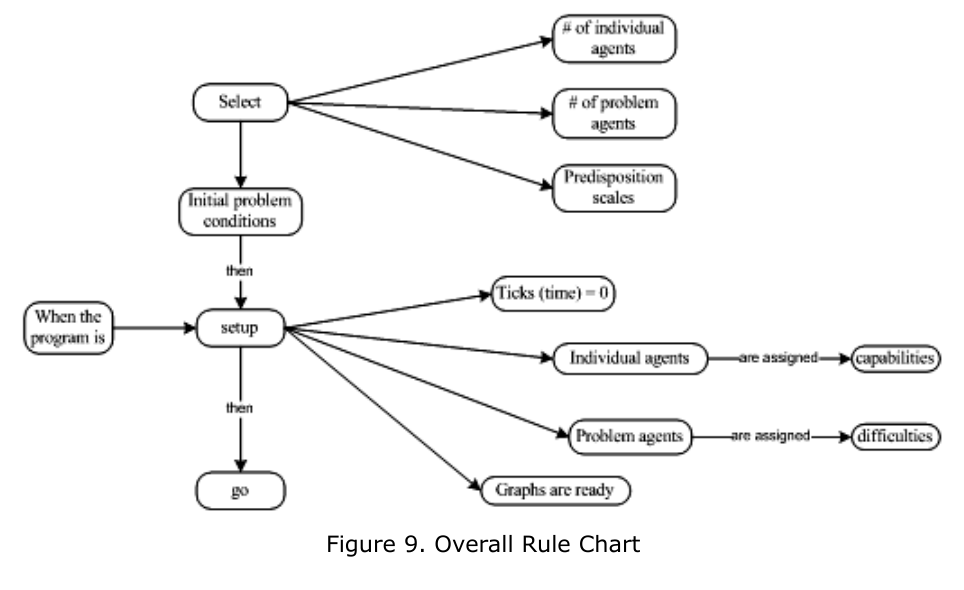
Figure 9. Overall Rule